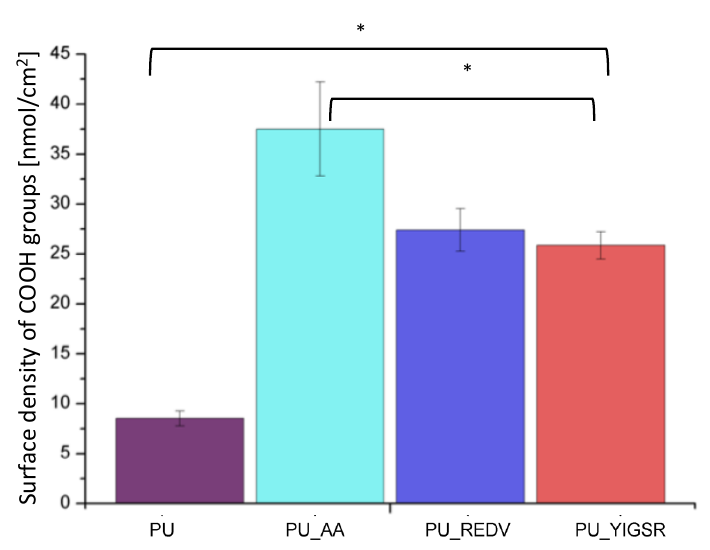
Figure 6. Results of TBO assay (MV ± SD, n = 4), *: p < 0.05.